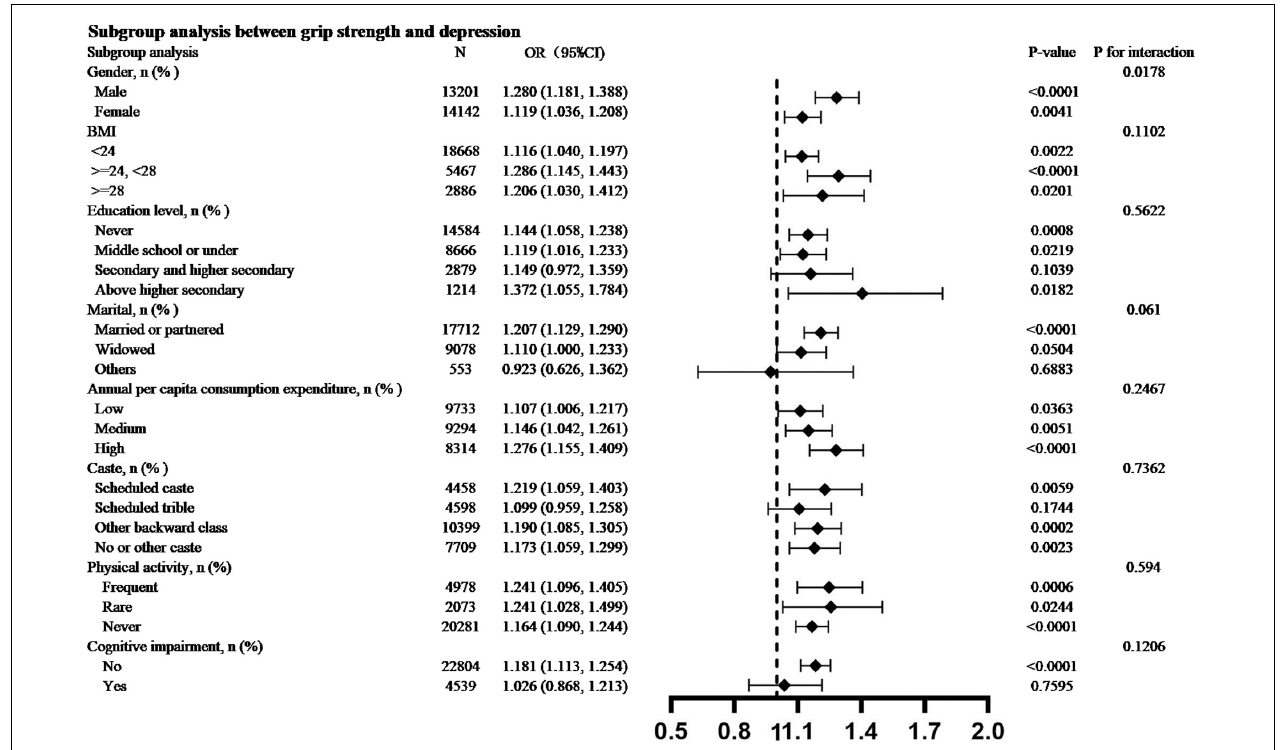
FIGURE 3 | Subgroup analysis between low grip strength and